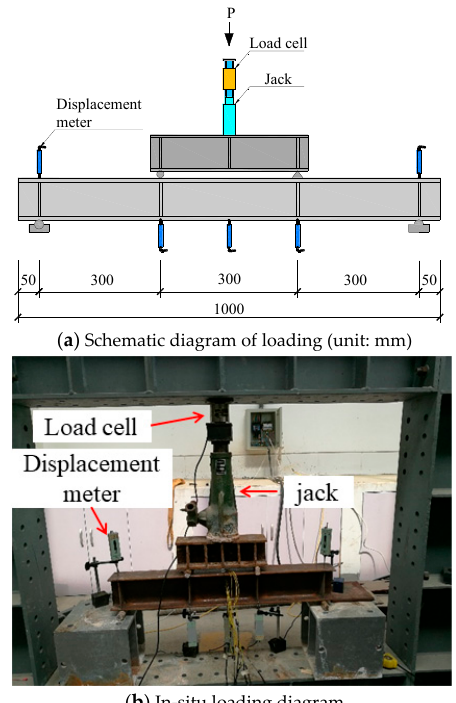
( b ) In ‐ situ loading diagram Figure 4. Loading diagram. Figure 4. Loading